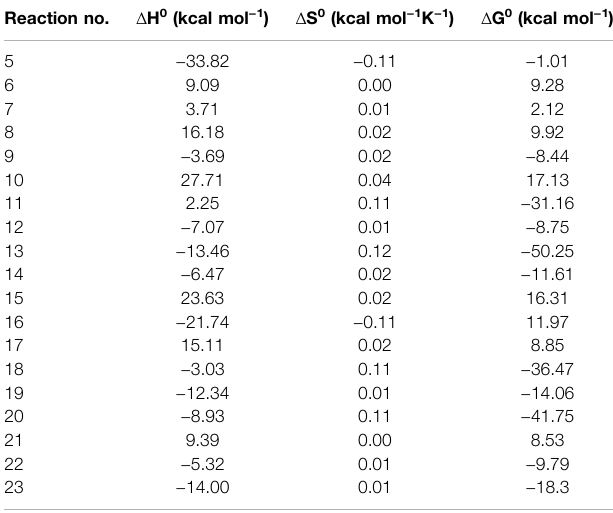
(P5) and methoxy radical through ipso-addition reaction involving a transition state (TS 10 ) with energy barrier of 4 kcal mol − 1 . The exothermic ipso-addition reaction has an energy of 6.5 kcal mol − 1 .